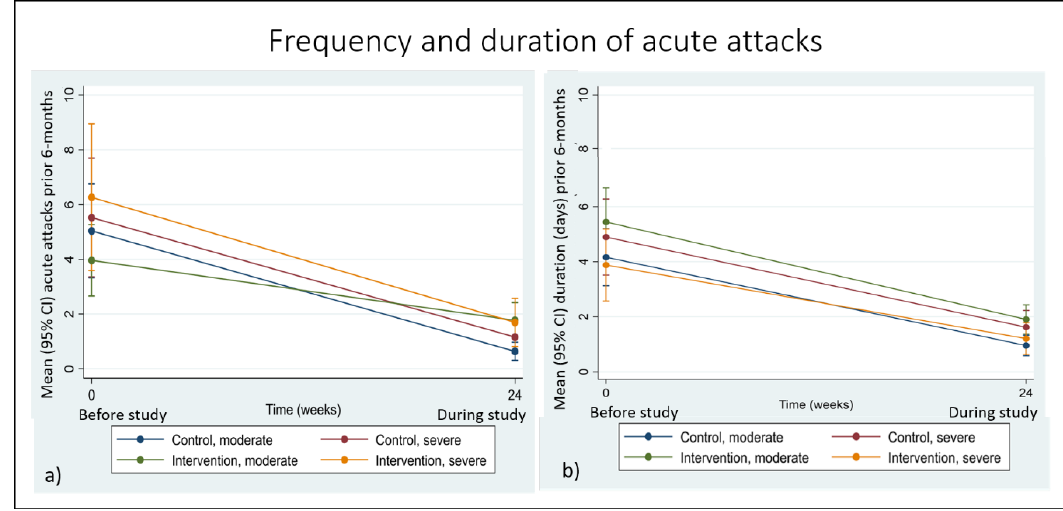
Figure 5. ( a ) Frequency and ( b ) duration of acute attacks by group and stage over 24